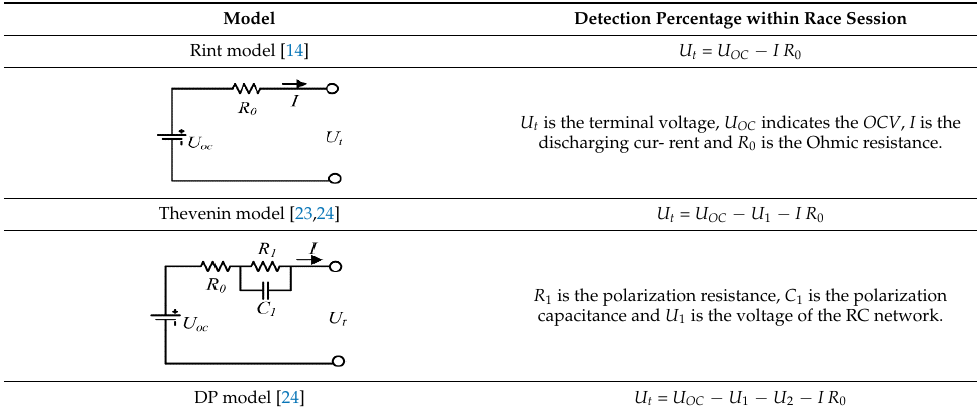
Figure 2. Dual polarization equivalent circuit model with two RC branches. Table 1. Common equivalent circuit battery models. Table 1. Common equivalent circuit battery